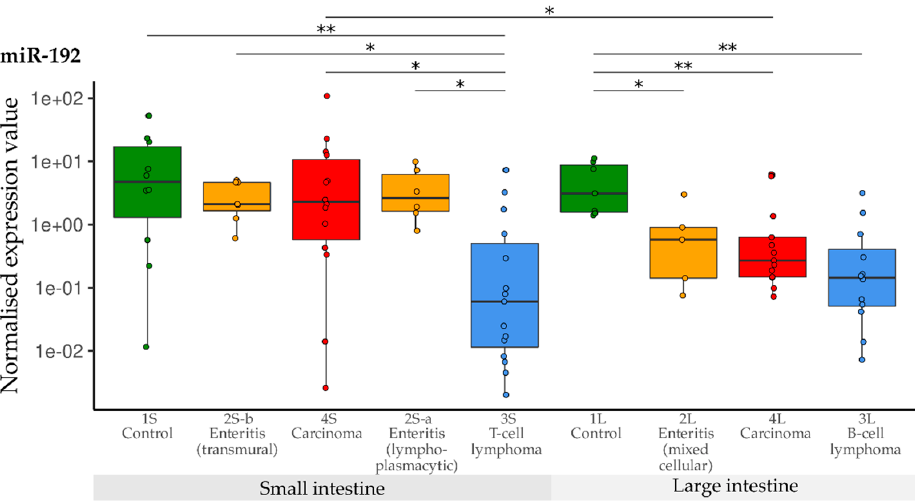
Figure 7. Expression levels of miR-192 in different groups (control, enteritis, carcinomas, lymphomas of the small and large intestine). The absolute miRNA copy number was related to the internal normaliser RNU6B. Results are shown as normalised expression values with a log10 scale. * p < 0.05, ** p < 0.005. Green control group, yellow enteritis, red carcinoma, blue lymphoma When compared with the controls, expression of miR-194 was significantly lower in the small intestine groups 2S-a, 3S and 4S. Only the levels in transmural enteritis cases (2S-b) were in the normal range. In the large intestine groups, down-regulation of miR- 194 was observed in B-cell lymphoma (3L) when compared with control tissue samples (1L) (Figure 8). Figure 8. Expression levels of miR-194 in different groups (control, enteritis, carcinomas, lympho- mas of the small and large intestine). The absolute miRNA copy number was related to the internal normaliser RNU6B. Results are shown as normalised expression values with a log10 scale. * p < 0.05, ** p < 0.005, *** p < 0.0005. Green control group, yellow enteritis, red carcinoma, blue lymphoma Compared with the controls, expression of miR-126 was significantly lower in the groups with lymphoplasmacytic enteritis (2S-a), lymphoma (3S) and carcinoma (4S) of the